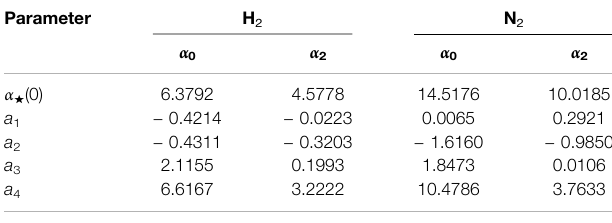
FIGURE 3 | (Color online) Isoenergy Contour plot for a positron around the hydrogen molecule fi xed at the equilibrium bond distance. Contours start at − 8.4 eV ( + ) with a level incremental of 0.5 eV. The plot correspond to a model potential with κ =1, ρ =1.85 and γ =1